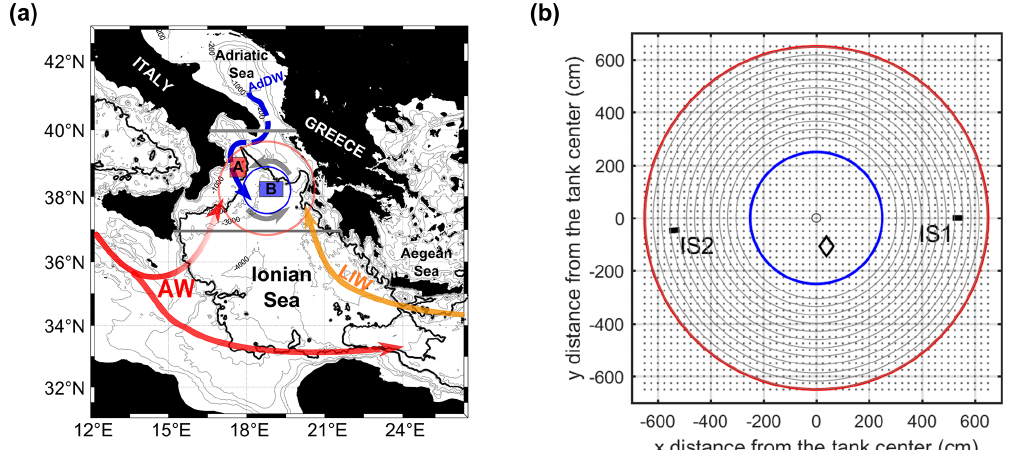
Figure 1. Panel (a) is a map of the study area in the Ionian Basin with a simplified circulation scheme, which changes according to the BiOS regime. Gray horizontal lines indicate the geographical limits within which the mean vorticities above and below the 2200m isobath were calculated. Rectangles A and B indicate the areas where density data (CMEMS reanalysis) were averaged. Concentric rings represent the simplified laboratory tank scheme. The acronyms used in the figure are as follows: AW is Atlantic Water, LIW is Levantine Intermediate Water, and AdDW is Adriatic Deep Water. Panel (b) is a top view of the tank: the slope area is between the red and blue circles, and the deep flat-bottom area is inside the blue ring. Dense-water injectors are placed at IS1 and IS2. A diamond near the center shows the location of the Cp3 profiler. Concentric gray rings indicate intersections of the laser sheet levels with the slope. Gray dots indicate regular x – y grid nodes for the tank velocity field (subsampled every five nodes for clarity). The map in panel (a) was created from the bathymetry data (ETOPO2v2, NOAA, World Data Service for Geophysics, Boulder, June 2006, https://doi.org/10.7289/V5J1012Q) using MATLAB